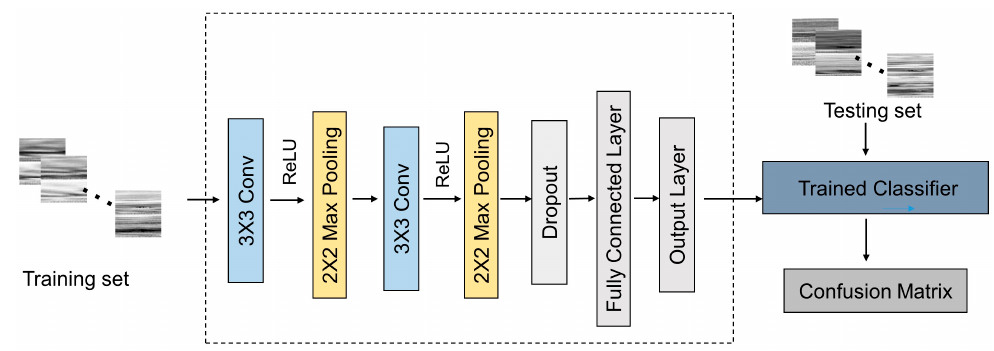
Figure 6. Flowchart of classification process.